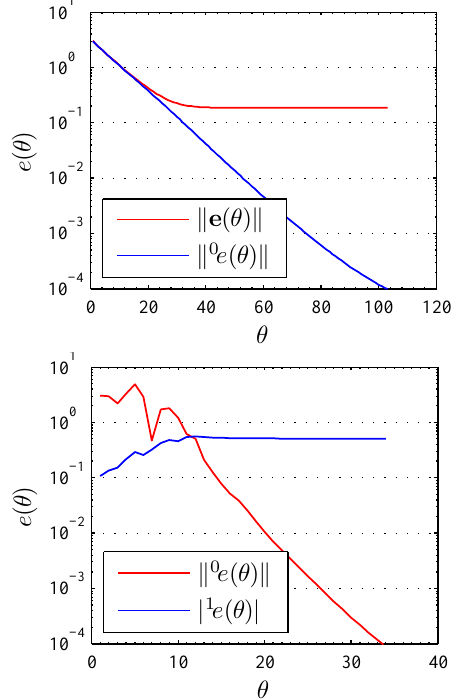
Figure 11. Convergence: egalitarian solution (top) and prioritarian solution